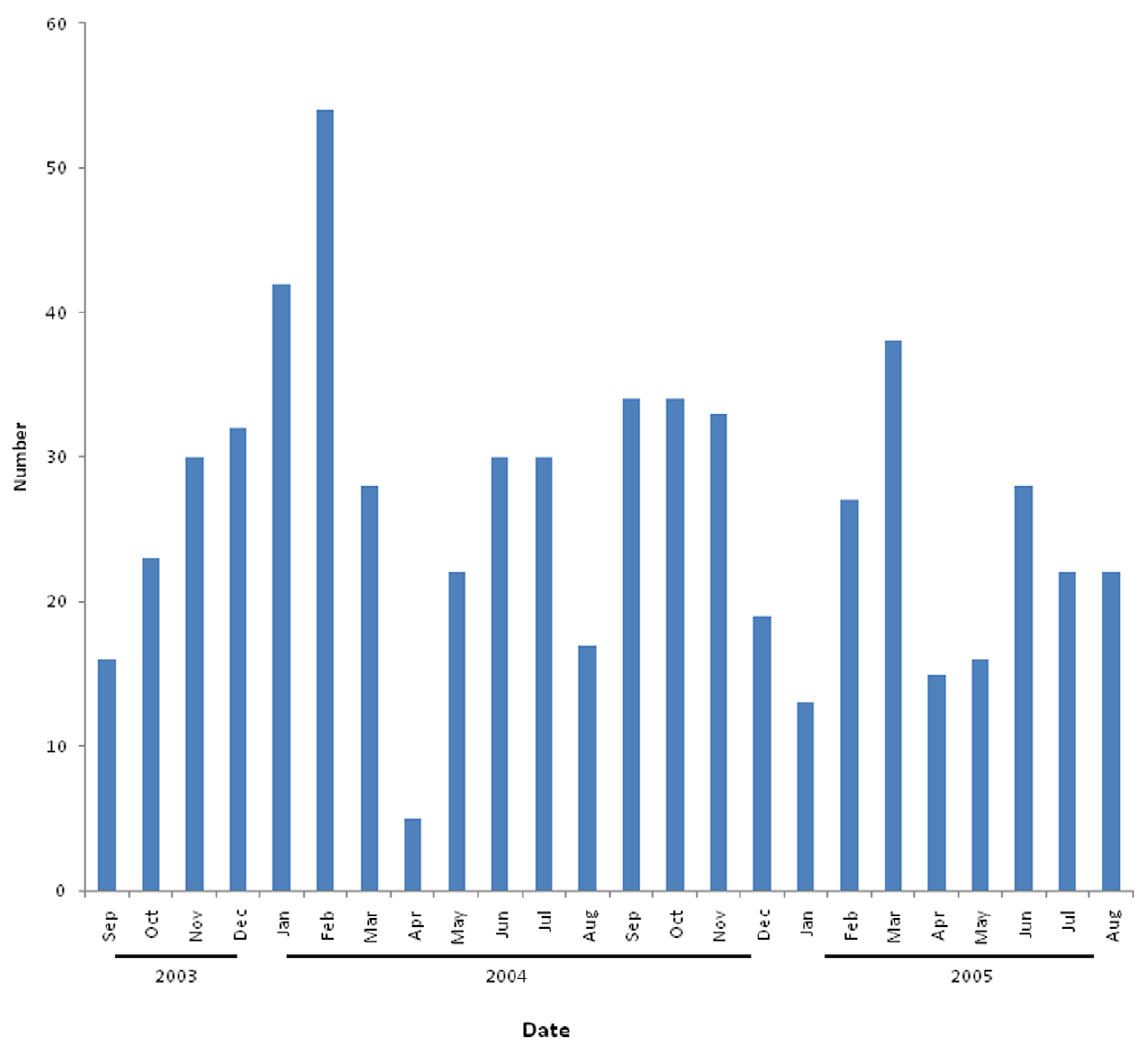
Figure 1. Seasonality of HRV detections among enrolled hospitalized patients and outpatients with influenza-like illness, Sa Kaeo Province, Sept 1, 2003–Aug 31, 2005.